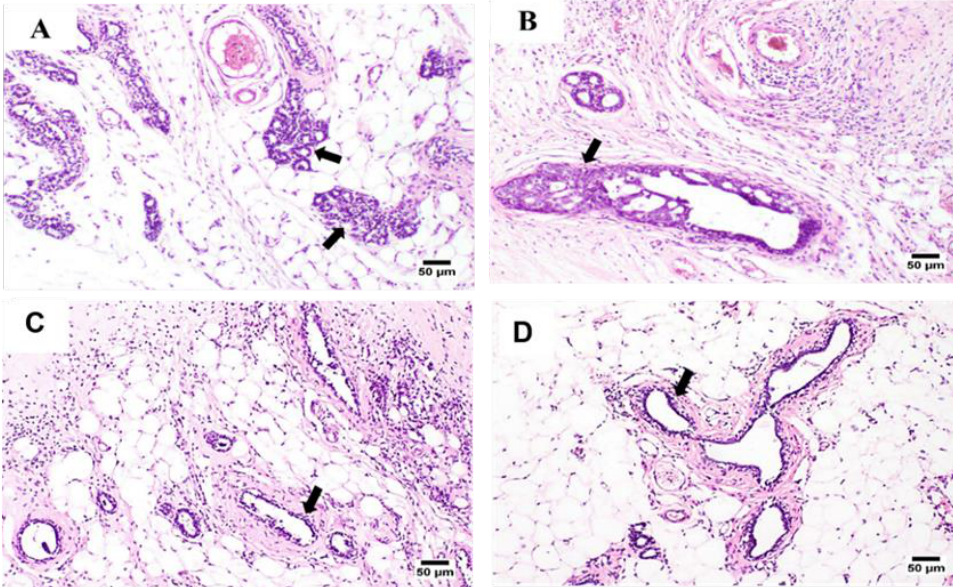
Figure 7. Photomicrographs display some histopathological appraisals (arrows), which were detected in the mammary gland tissues from six treatment groups: ( A ) the unmedicated group showing numerous clusters of neoplastic cells with marked edema; ( B ) the group receiving (5-FU/MTX) saline solution showing proliferating neoplastic cells with inflammatory reactions; ( C ) the group receiving hydrogel formula A showing few proliferating mammary ducts and inflammatory cells infiltration; and ( D ) the group receiving hydrogel formula C showing few neoplastic cells forming ducts with mild inflammatory edema; 100× (H&E).